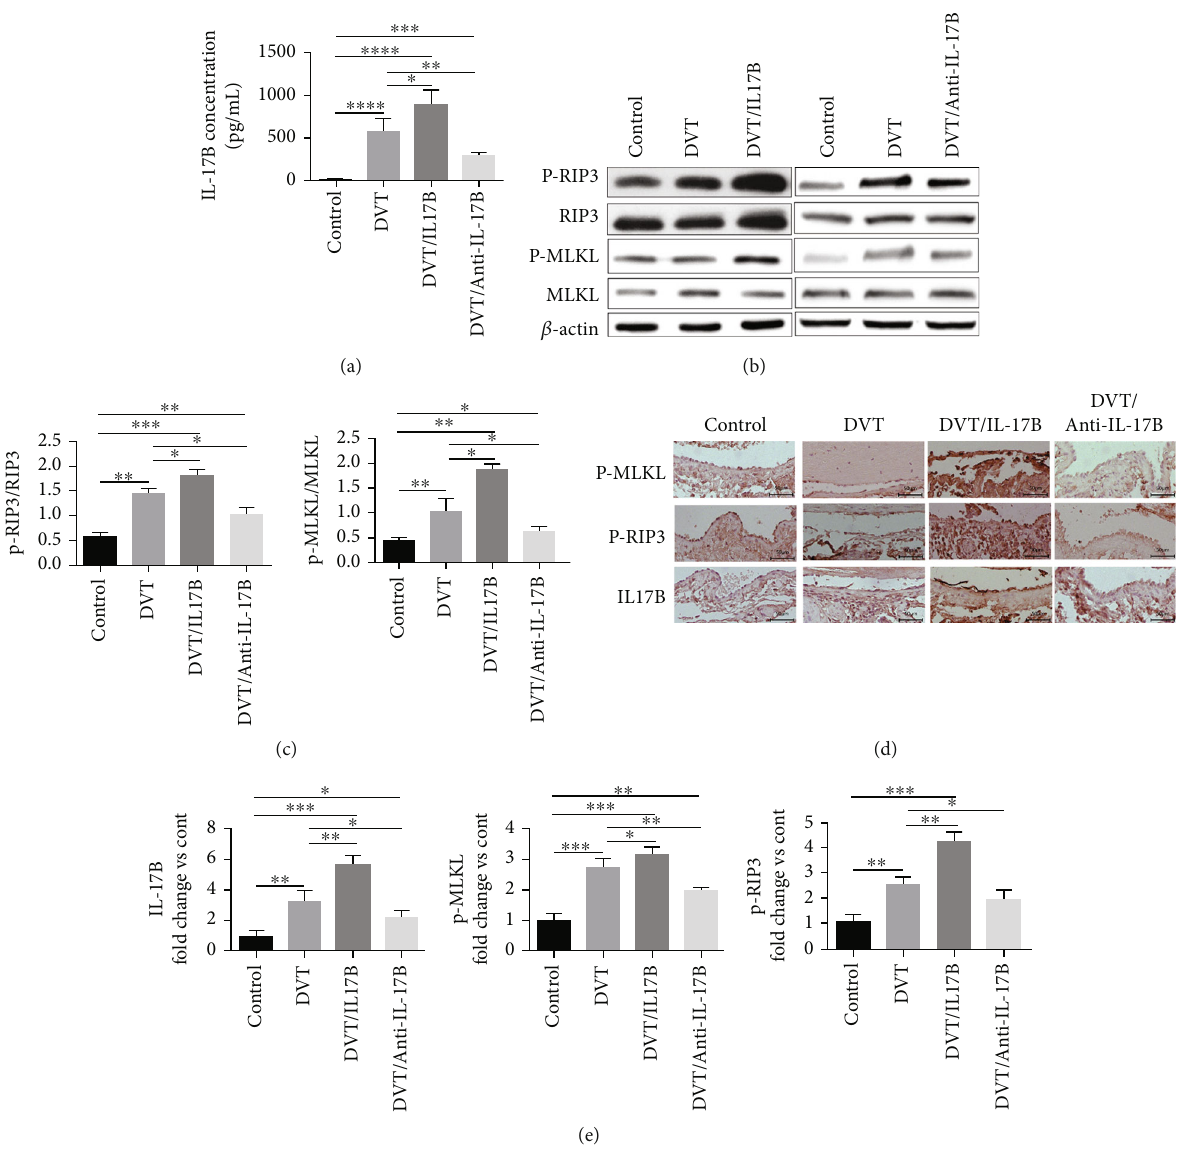
Figure 4: RIP3 and MLKL were enhanced by IL-17B and decreased by IL-17B antibody in thrombogenic IVC tissues. (a) ELISA was used to detect the expression of IL-17B in the IVC wall in each group. (b) Western blot of RIP3, p-RIP3, MLKL, and p-MLKL proteins in the IVC wall, using β -actin as the internal reference. (c) ImageJ image software analysis was used to determine the p-RIP3/RIP3 and p-MLKL/MLKL ratios in the IVC wall in each group. The bar charts show the ratio of protein gray value to total protein gray value. (d) Immunohistochemistry was used to determine the expression of p-MLKL, p-RIP3, and IL-17B proteins in each group ( n = 6 , scale = 50 μ m, 200x). The positive expression of the protein is shown as sepia particles. (e) The positive expression of the proteins was observed by an optical microscope. Image-Pro Plus 6.0 software was used to calculate the positive rate. The bar charts show the ratio of positive expression of the protein value to the control group. Six mice were tested in each group. ANOVA was used for statistical analysis. ∗ P < 0 : 05 , ∗∗ P < 0 : 01 , and ∗∗∗ P < 0 : 001